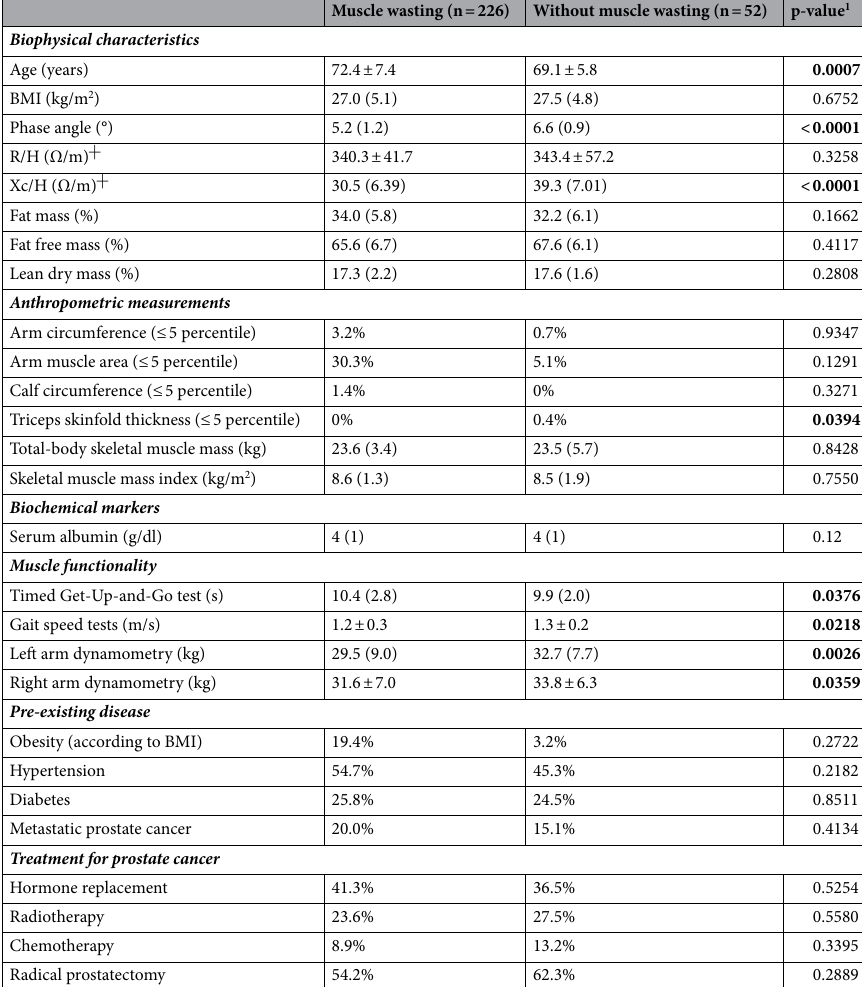
Table 1. Comparative analysis between subjects’ characteristics according to BIVA diagnosis. BIVA bioelectrical impedance vector analysis, BMI body mass index. Significant values are in bold. 1 Obtained by Student’s t -test or Mann–Whitney U , according to distribution Data presented as means ± SD or medians 2 (IQR). For proportion comparisons, a χ test was computed. ┼ These strong associations are expected as part of the definition of wasting used to classify